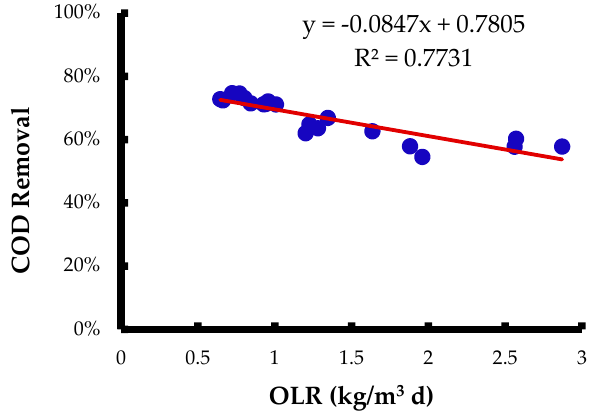
y = ‐ 0.0847x + 0.7805 R² = 0.7731